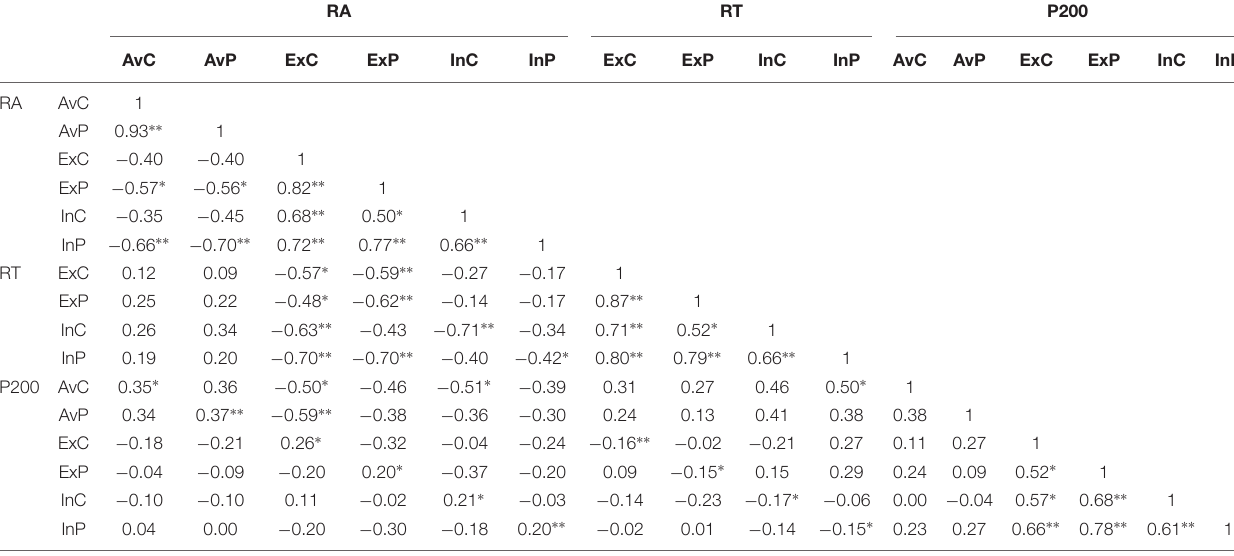
TABLE 5 | The correlational analysis for the magnitude of the P200 and the RA and RT estimates. RA RT